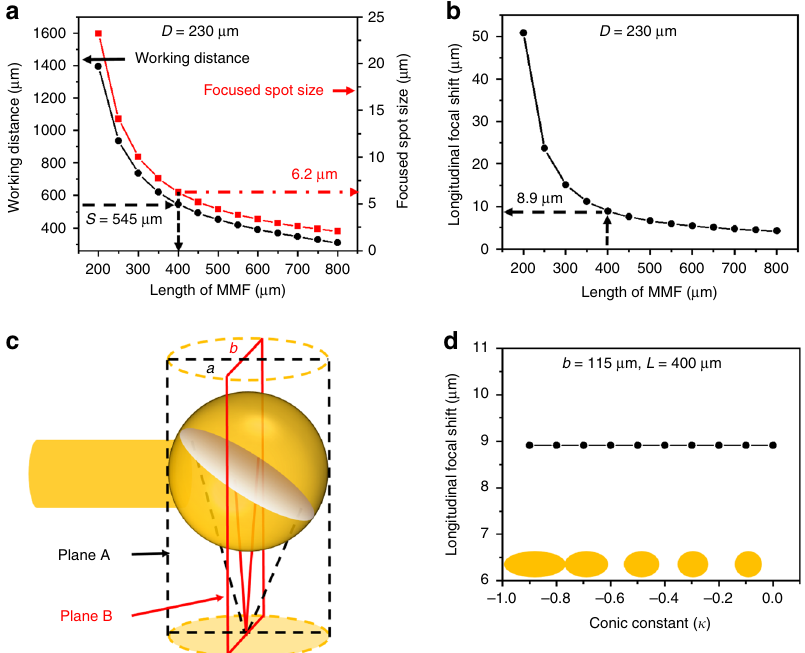
Fig. 2 Ray-tracing simulations on the microprobe design and performance. a Calculated working distance and focused beam spot size versus the length of the multi-mode fi ber (MMF) spacer with a fi xed ball lens diameter of 230 µ m. b Calculated longitudinal focal shift for wavelength range from 700 to 900 nm versus the length of the MMF spacer with a fi xed ball lens diameter of 230 µ m. c Schematic of the fi ber ball lens with a top projected ellipse (yellow dashed line) of a major axis length a and a minor axis length b . Focused beams in the plane A that contains the major axis (black dashed lines) and the beams in the plane B that contains the minor axis (red solid lines) are illustrated, respectively. d Calculated longitudinal focal shift in the plane A under different conic constants when the radius of the fi ber ball lens (that is, the minor axis length) is 115 µ m and the MMF length is 400 µ m. The representative yellow solid ellipses illustrated in the inset have a conic constant of − 0.1, − 0.3, − 0.5, − 0.7, and − 0.9,